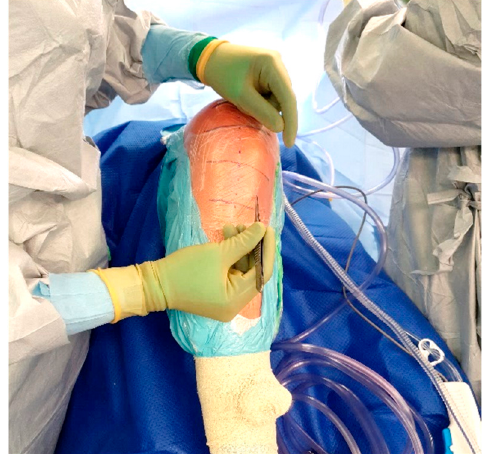
Figure 3. Location of IO insertion on a right knee.